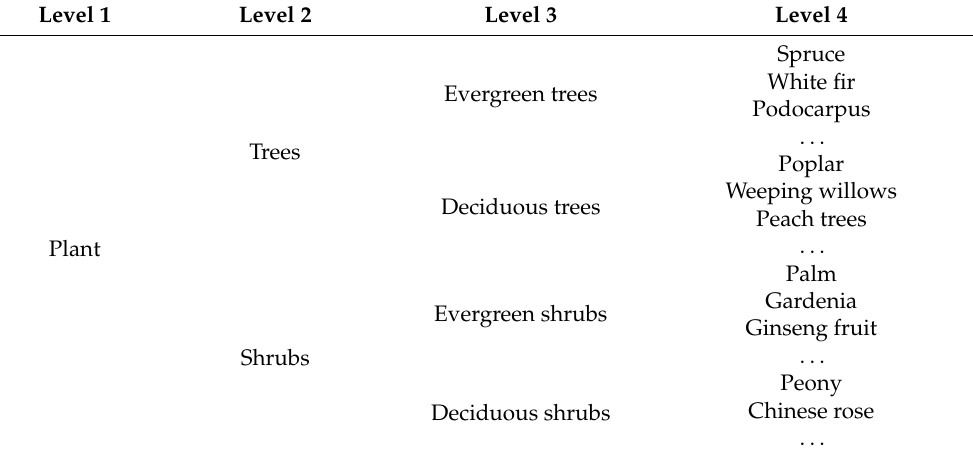
Table 1. Examples of landscape plant